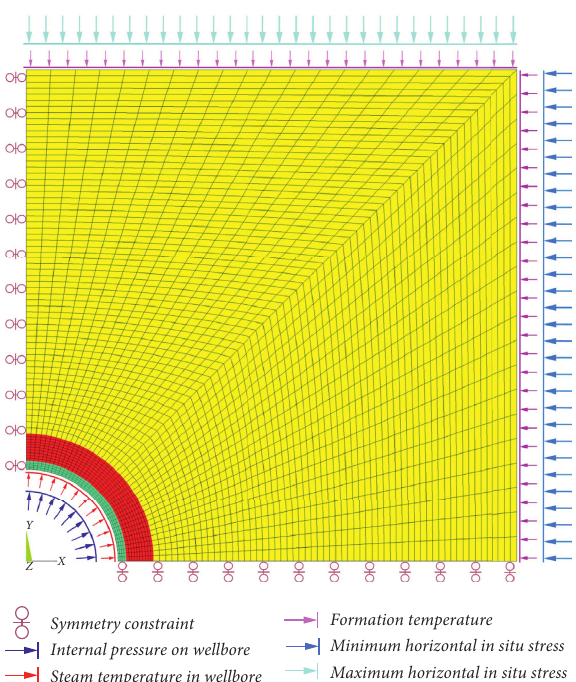
Figure 6: The boundary conditions and loading conditions of the finite element model.